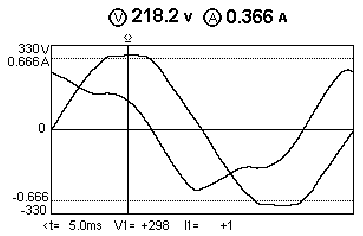
Figure 15. The phase voltage and the neutral current when two compact fluorescent lamps are supplied at different phase L 1 and L 2 (set